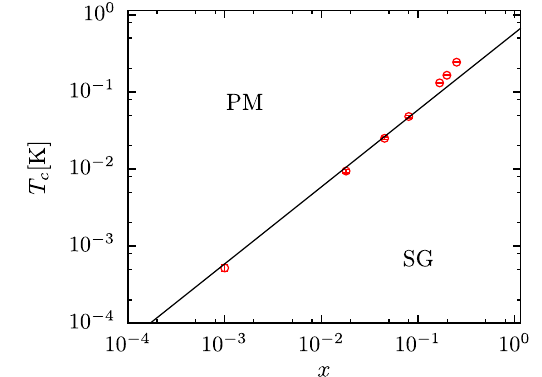
FIG. 3. Log-log plot of the high-dilution limit of the transition temperature T c versus the concentration x phase diagram ob- tained from our simulations. The solid line separating the spin glass (SG) from the paramagnetic (PM) phase is a fit to the numerical data of the form T c ð x Þ ¼ ax with a ¼ 0 . 59 ð 1 Þ . The spin-glass phase therefore extends to the x ¼ 0 þ